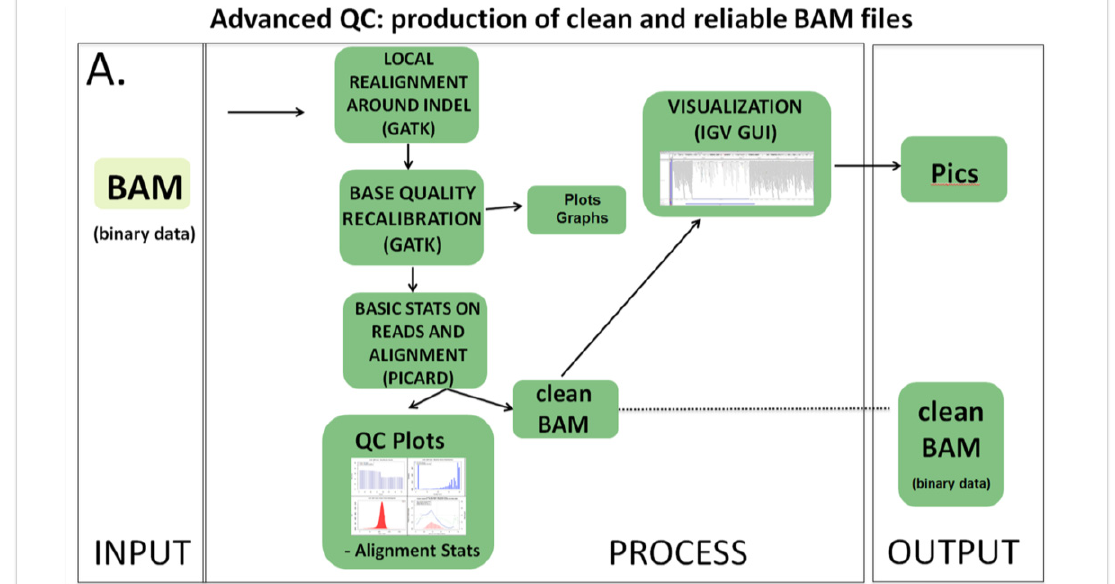
Figure 6. A snapshot of the general organization of the Advanced QC workflow (2.1.4). ( A ) After the basic QC, (cid:87)(cid:75)(cid:72)(cid:3) (cid:85)(cid:72)(cid:68)(cid:71)(cid:86)(cid:3) (cid:87)(cid:75)(cid:68)(cid:87)(cid:3) (cid:80)(cid:68)(cid:83)(cid:3) (cid:90)(cid:76)(cid:87)(cid:75)(cid:76)(cid:81)(cid:3) (cid:44)(cid:81)(cid:71)(cid:72)(cid:79)(cid:86)(cid:3) (cid:76)(cid:81)(cid:3) (cid:87)(cid:75)(cid:72)(cid:3) (cid:76)(cid:81)(cid:71)(cid:76)(cid:89)(cid:76)(cid:71)(cid:88)(cid:68)(cid:79)(cid:182)(cid:86)(cid:3)